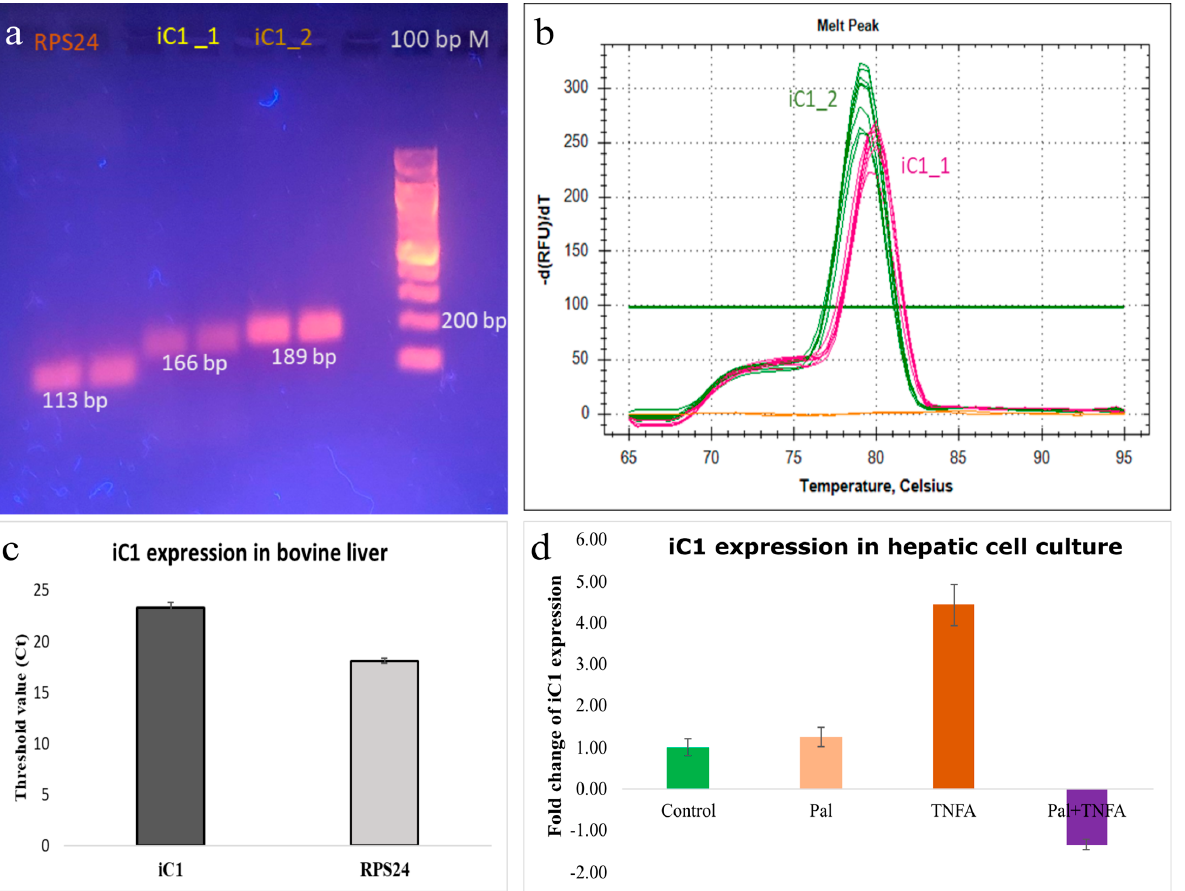
Figure 2. Gene expression of iC1 in bovine liver. Transcript of iC1 was tested using two pairs of primers (iC1_1 and iC1_2), resulting in successful amplification of a single amplicon (166 bp and 189 bp, respectively) shown by agarose gel electrophoresis ( a ). Melt curve analysis carried out after the end of qPCR amplification showed a single melt peak, suggesting a single PCR product amplified by each primer pair ( b ). Gene expression of iC1 in bovine liver tissue (n = 4), expressed in terms of threshold (Ct) value, showing successful amplification of iC1 and the endogenous reference gene, RPS24 ( c ). Results of iC1 expression in conditioned medium are in fold change normalized to the RPS24 gene with the control culture as a calibrator ( d ). Conditioned media of bovine hepatic cells collected 24 h post treatment with palmitate (Pal), tissue necrosis factor alpha (TNFA), and cocktail of Pal + TNFA. No-reverse transcriptase (NRT) and no-template control (NTC) were the negative controls of RT-qPCR